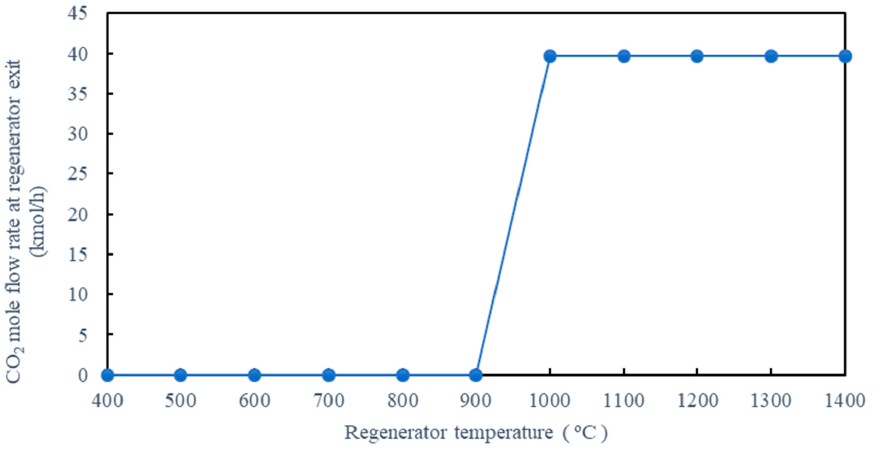
Figure 7. Effect of regenerator temperature on the CO 2 mole flow rate released from CaCO 3 at a gasifier temperature = 700 °C, S/F mass ratio = 1, CaO/F mass ratio = 2, and carbonator temperature = 600 °C.